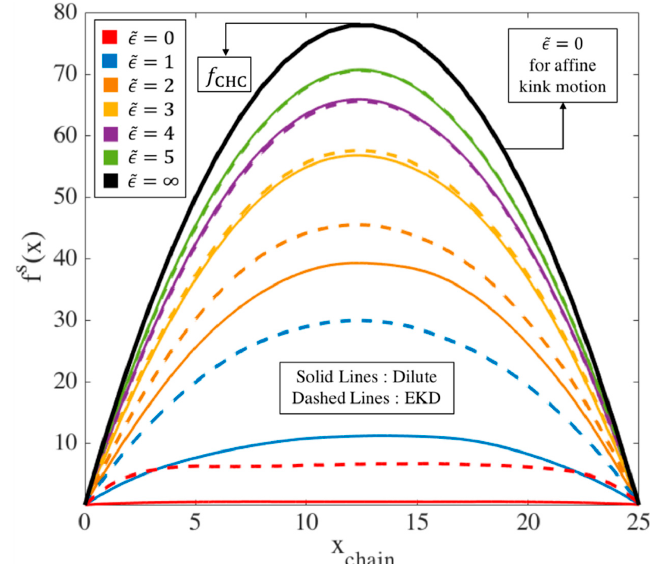
Figure 5. Evolution of tension distribution ( f s ( x ) ) along an L = 25 chain under affine motion, and for dilute and entangled chains, the latter simulated by the EKD method and averaged over an ensemble of 150 chains. The arrow at the peak of black curve shows the maximum tension value a chain of length L = 25 will achieve when fully unraveled for a dilute and an EKD chain, which is attained immediately in the kinked state under affine motion of kinks. The peak value of this maximum tension is given by Equation (7).